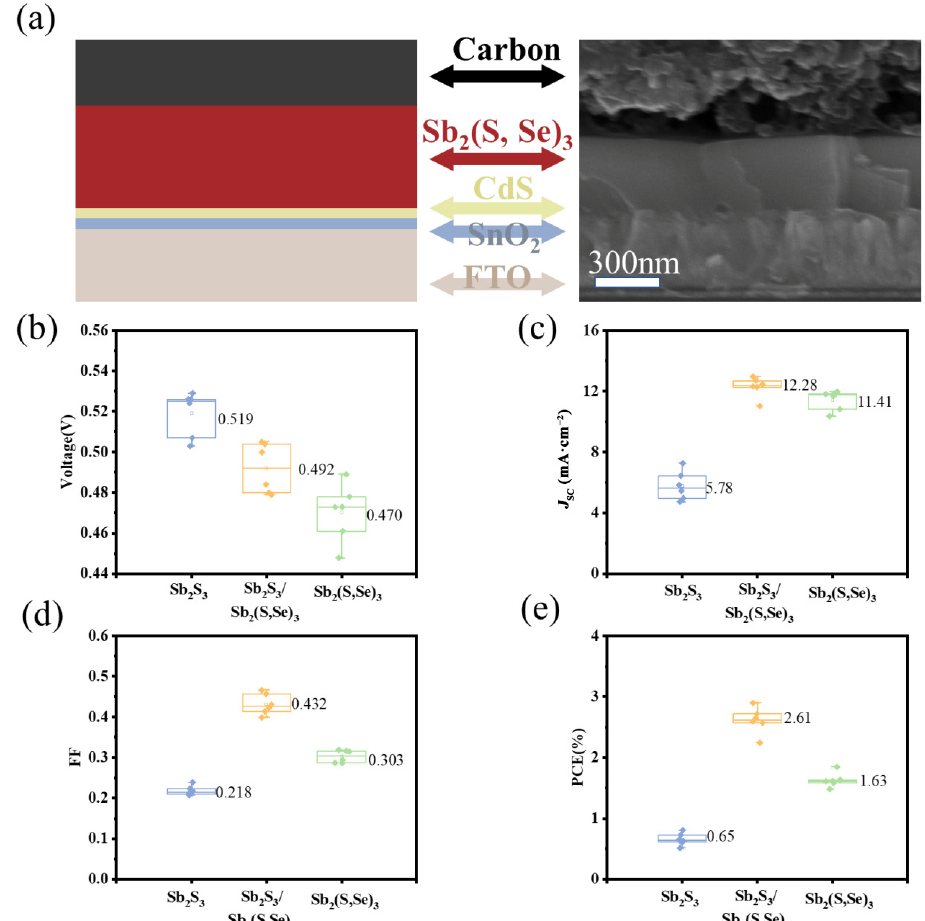
Figure 4. ( a ) Scheme and cross-sectional SEM image of carbon-based Sb 2 (S, Se) 3 solar cells without HTM. Statistical data obtained from the Sb 2 S 3 , Sb 2 (S, Se) 3 , and Sb 2 S 3 /Sb 2 (S, Se) 3 solar cells: ( b ) V OC , ( c ) J SC , ( d ) FF, and ( e ) PCE.